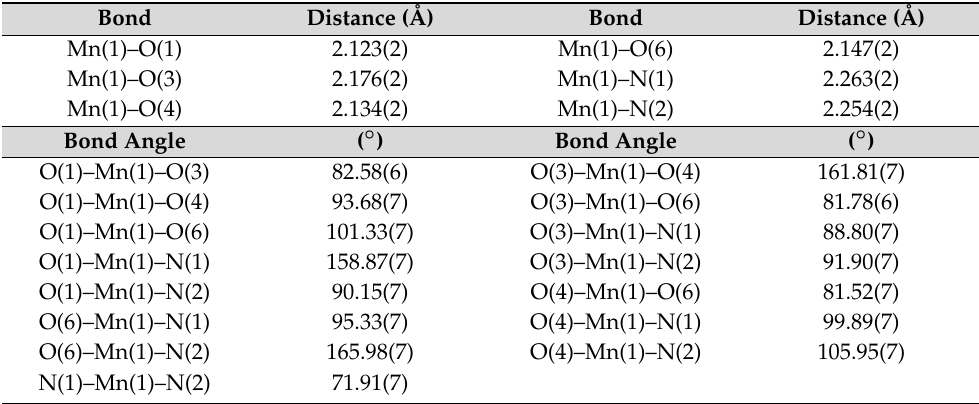
Figure 4. A drawing of the molecular structure of 9 with only the heteroatom labeling. Hydrogen atoms and solvate molecules are omitted for clarity. Table 3. Selected bond distances and angles for complex 9 .